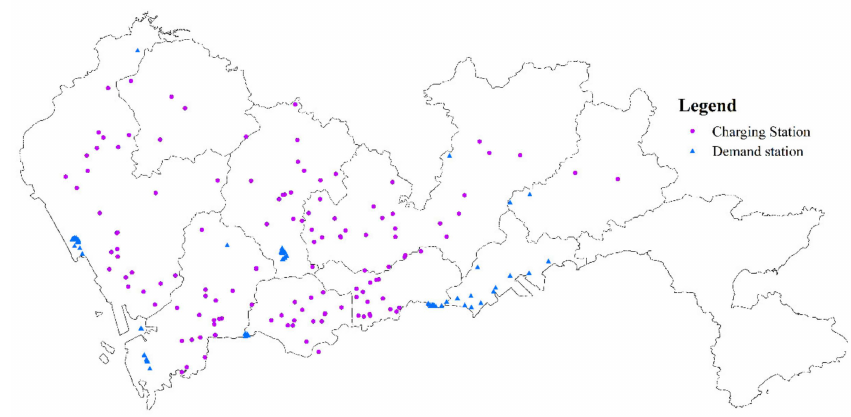
Figure 25. Spatial distribution of electric taxi charging demand.